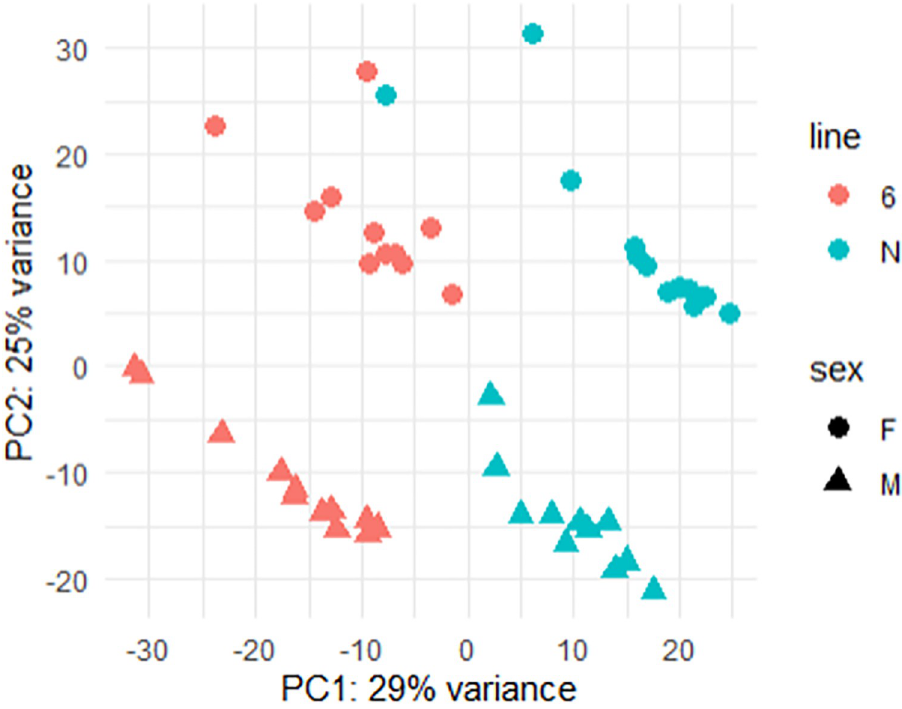
Fig 2. Principal component analysis of the gene expression in caecal tonsils in all samples. The first principal component contains 29% of the variance and may be attributed to the line effect and the second principal component contains 25% of the variance and may be attributed to the sex